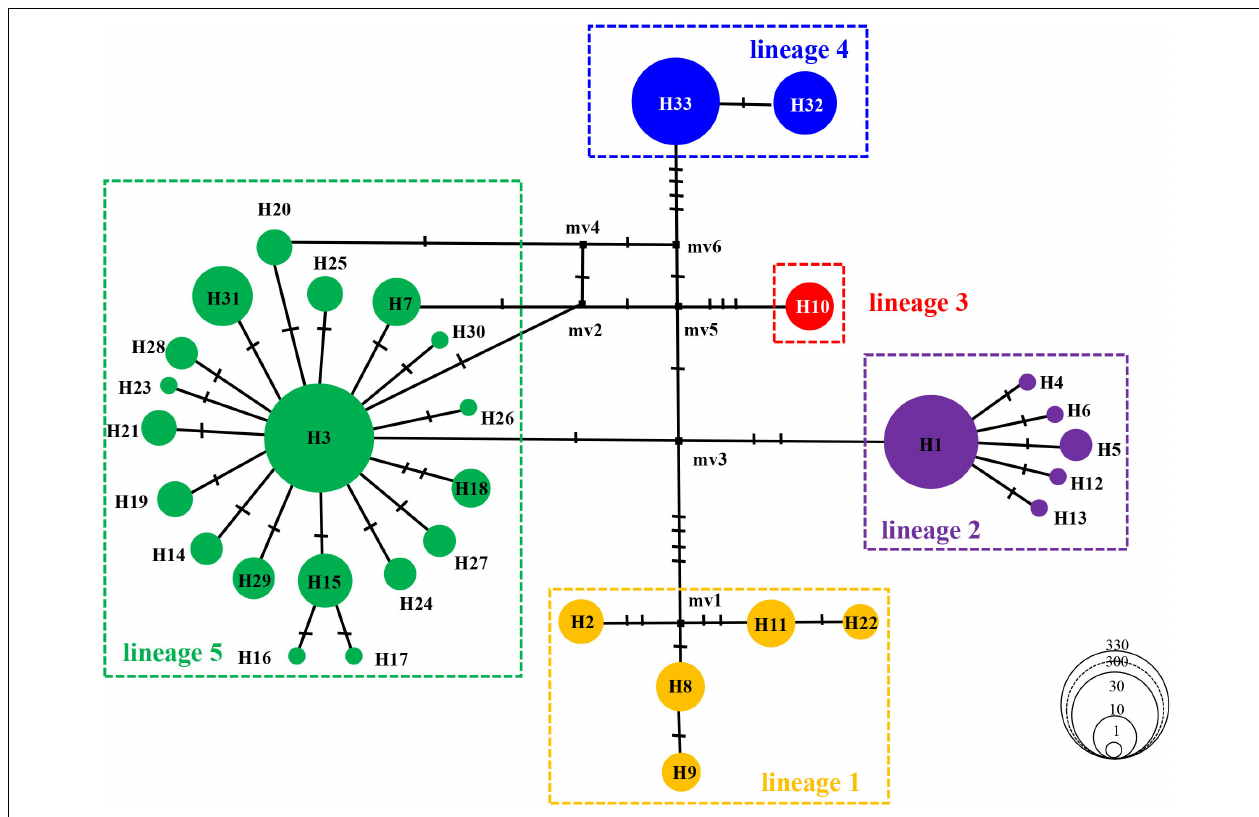
FIGURE 3 | Median joining network of mitochondrial DNA (mtDNA) cox 1 haplotypes in the northwest Pacific. The size of each circle is proportional to the frequency of haplotypes. Color coding of lineages as in Figure 1 . The small black squares represent extinct or unsampled haplotypes.